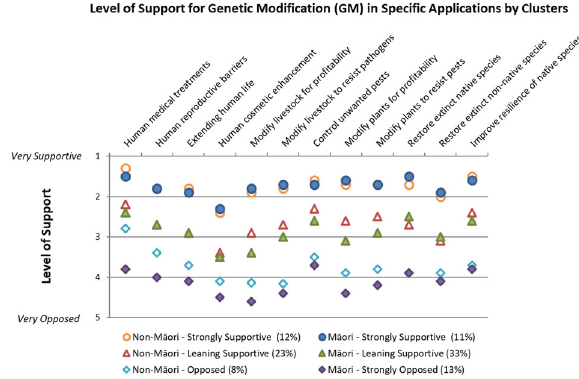
Fig. 3 Level of support for genetic modi fi cation (GM) in speci fi c applications by cluster types. Circles represent Strongly Supportive clusters; triangles represent Leaning Supportive clusters; and diamonds represent Opposed clusters. In each of the three perspectives, the opaque points are M ā ori clusters and the outlined points are non-M ā ori clusters. In the Strongly Supportive clusters, both M ā ori and non-M ā ori have similar supportive stances to the use of GM in each of the applications. However, in the other four clusters, M ā ori are generally less supportive (Leaning Supportive cluster) or more opposed (Opposed cluster) than their non- M ā ori counterparts.